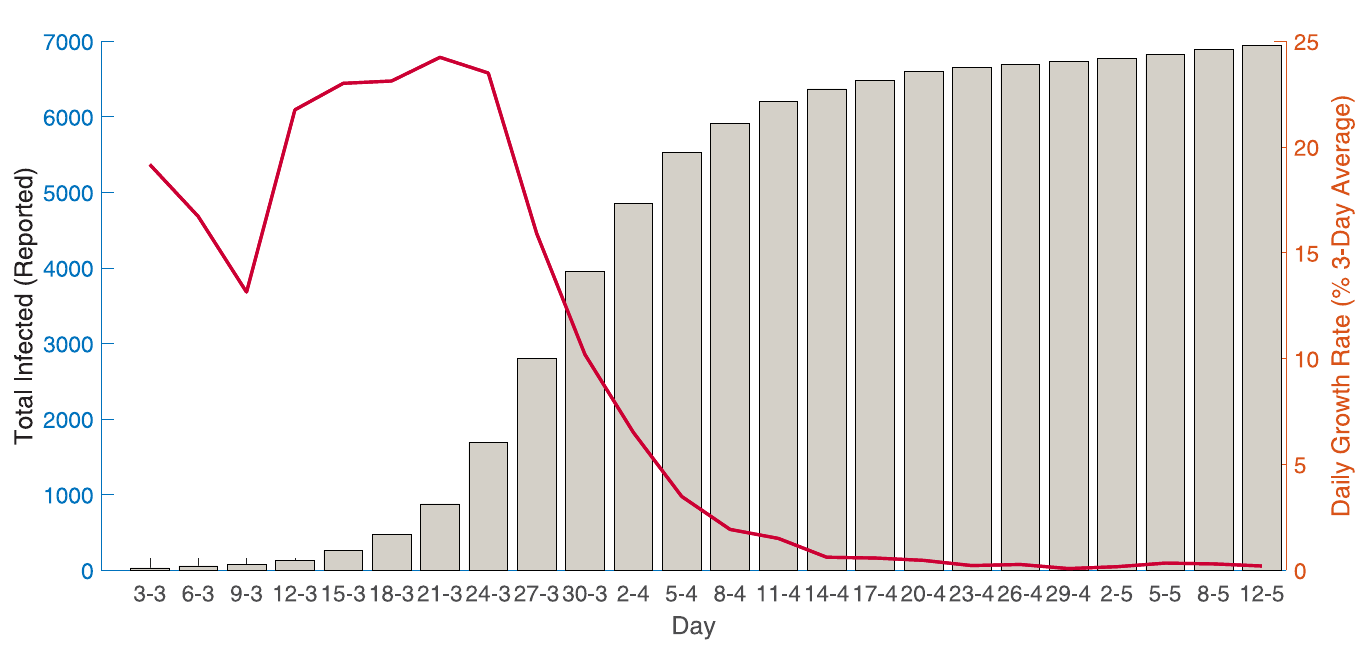
Fig 1. COVID-19 infected cases and 3-day average growth rate.